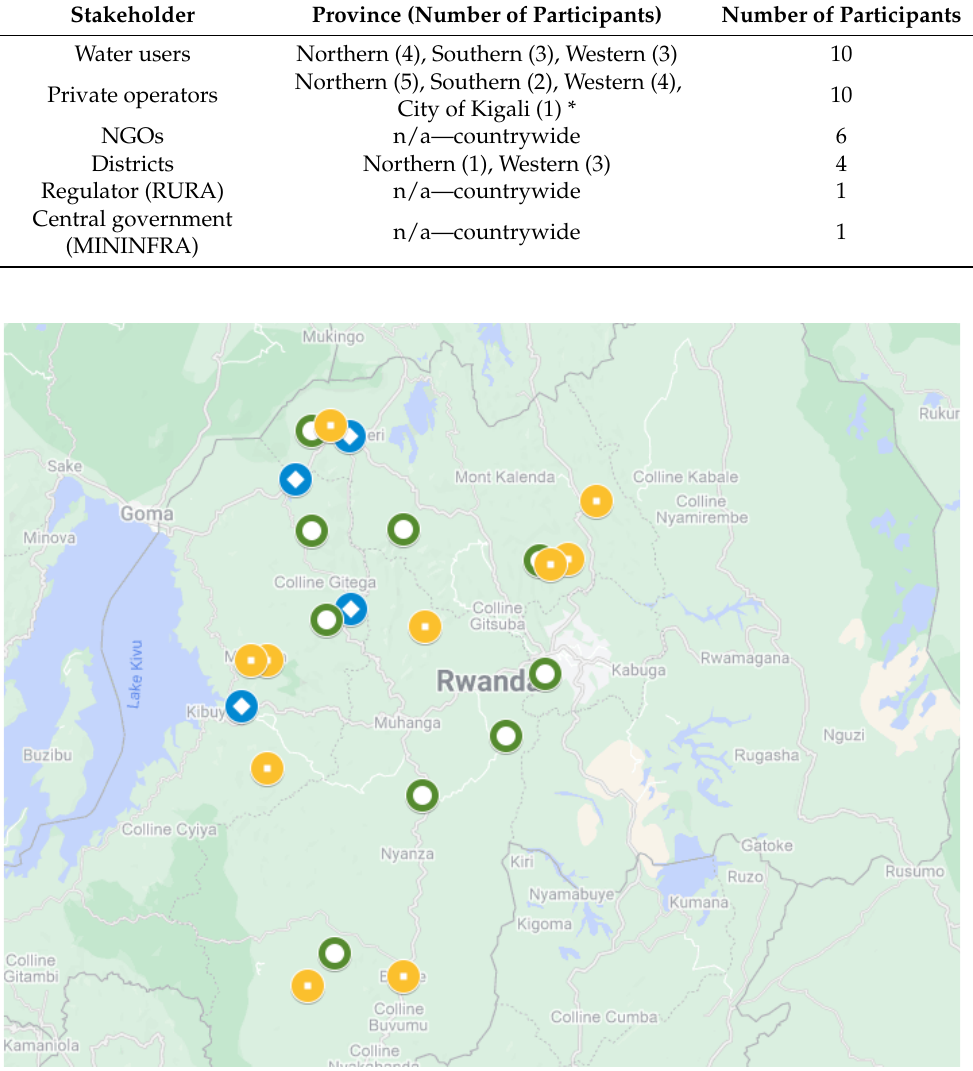
Figure 1. Geographic locations of the district, PO and water user participants (PO — private operator).